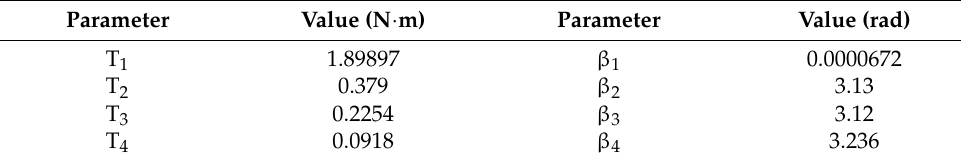
Table 5. Parameters of the mathematical equation for the cogging torque.